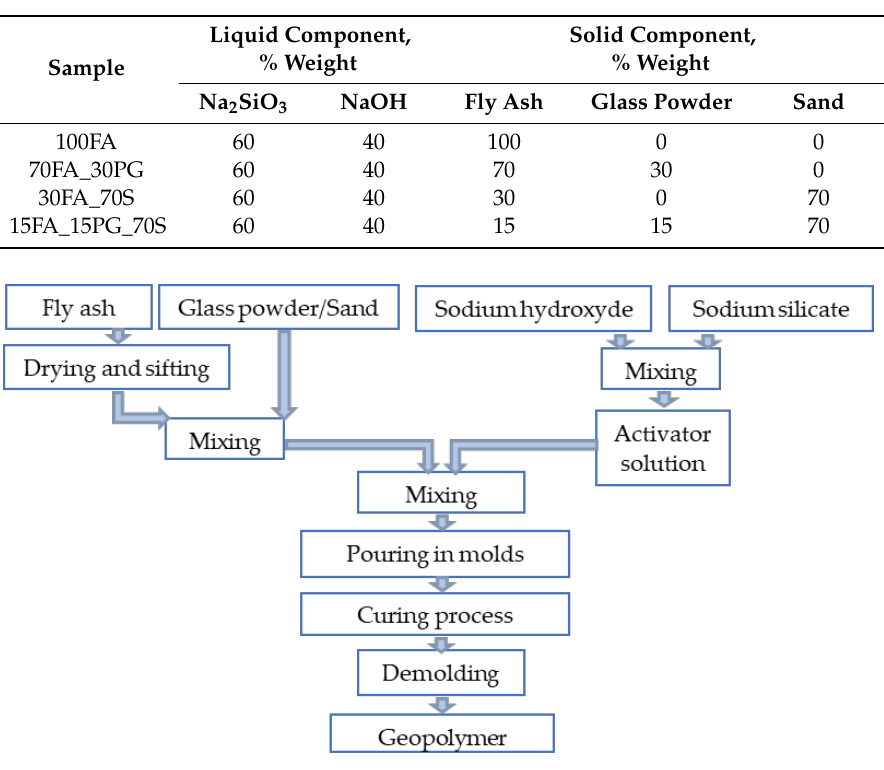
Table 3. Samples components mix proportion.